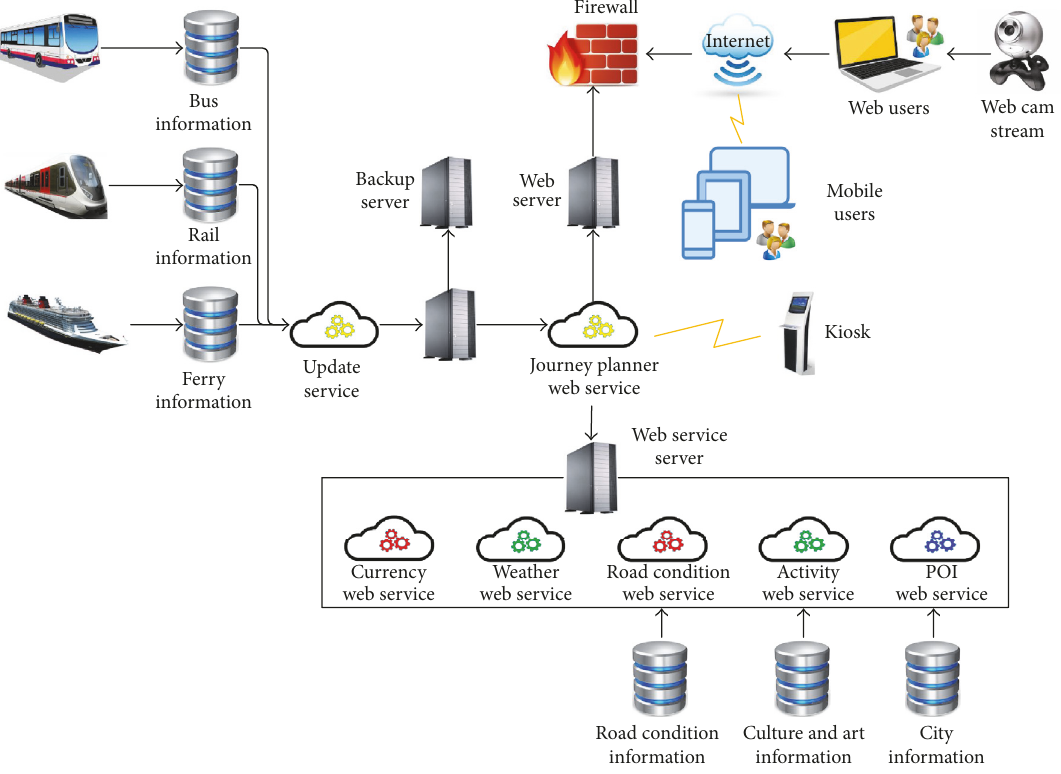
Figure 7: System architecture.